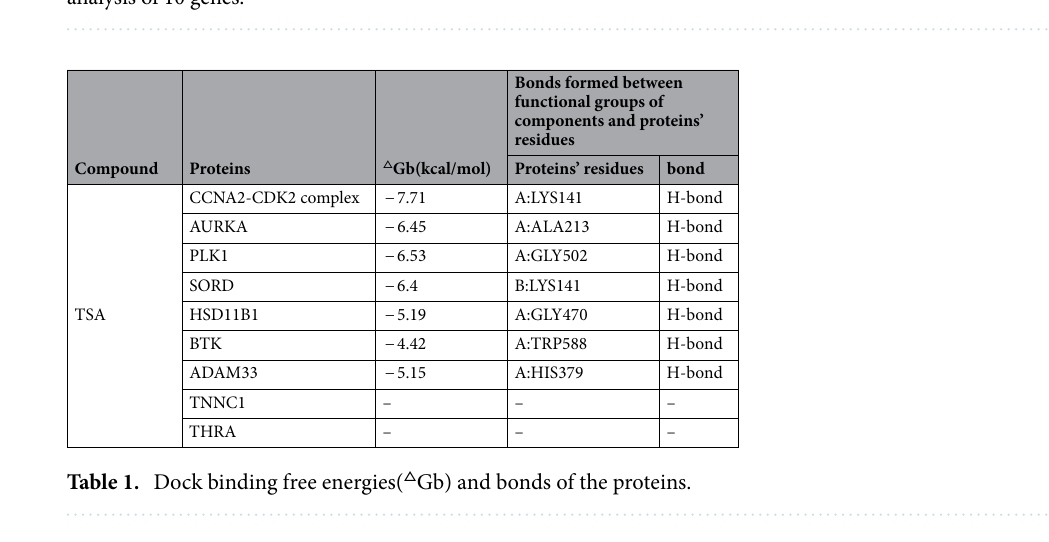
Figure 4. ( A ) Genes analyzed by GEPIA that affect the overall survival of LUAD patients. ( B ) Correlation analysis of 10 genes.